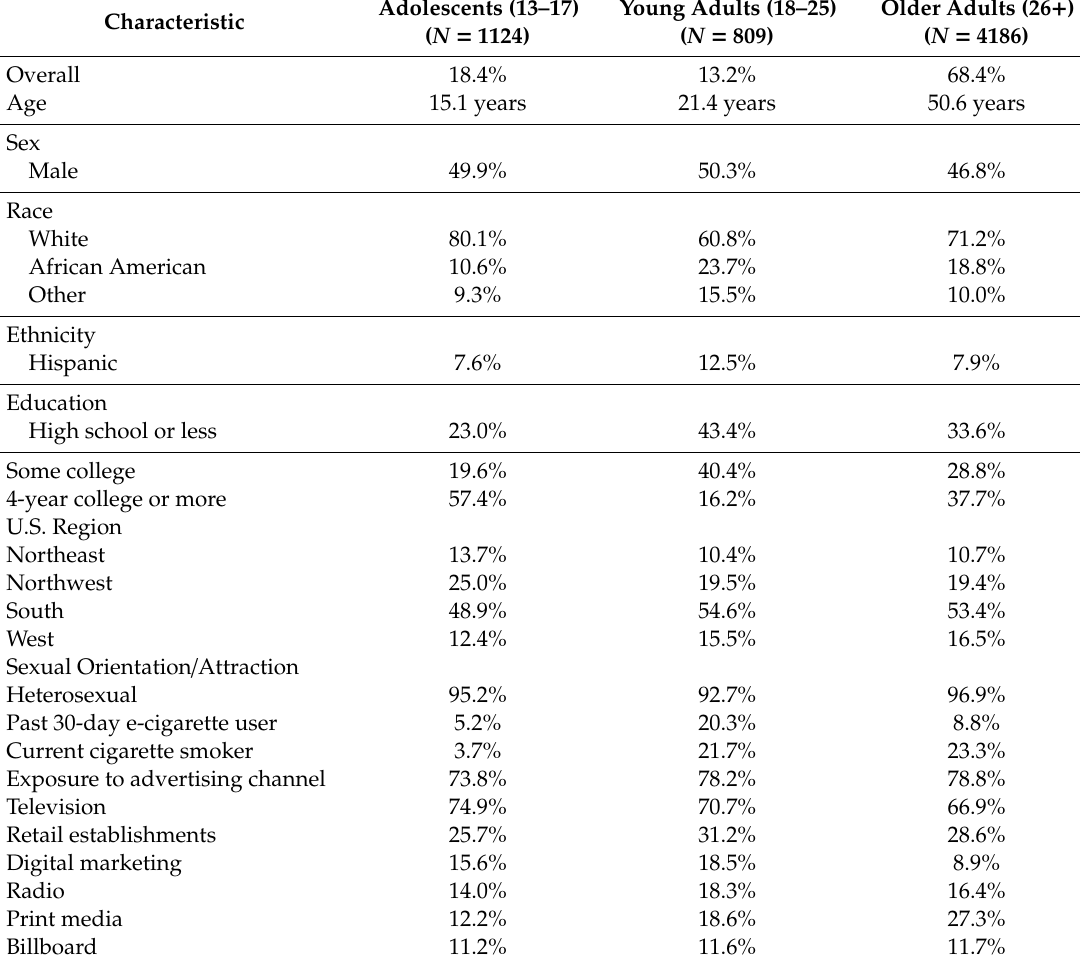
Table 1. Sample characteristics (unweighted).